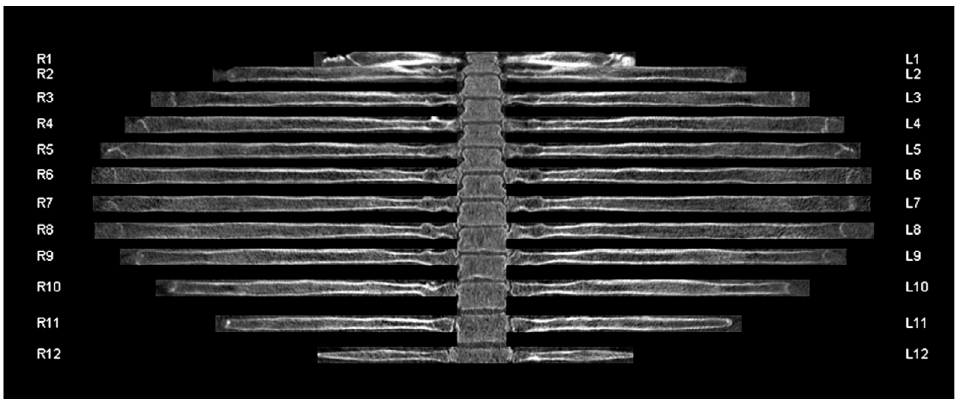
Figure 1. Unfolded rib view of a 41-year-old male patient involved in a high-speed motor vehicle accident with no evidence of acute trauma injury. The curved view and anatomical labels were automatically computed by the reconstruction algorithm. R1-12 refers to the 1st to 12th rib of the right hemithorax. L1-12 refers to the 1st to 12th rib of the left hemithorax.